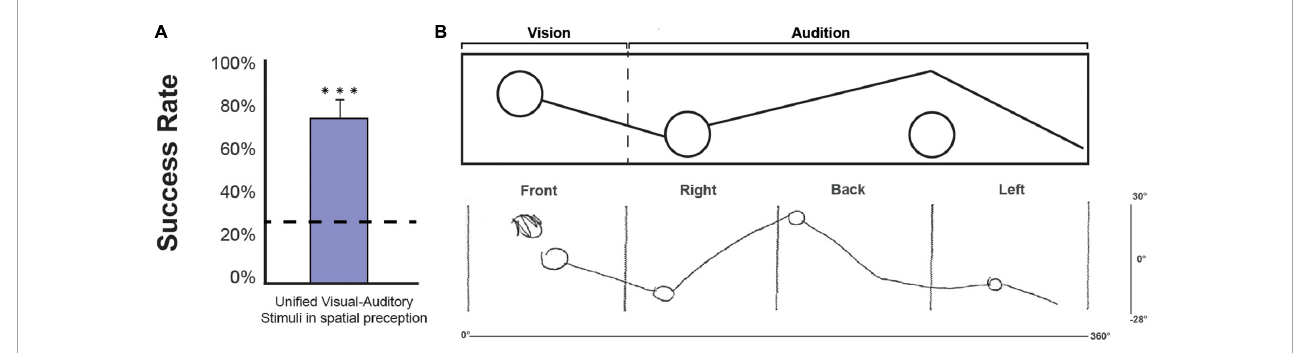
FIGURE5 (A) Group result for shapes that began in the visual field and continued auditorily. We performed a one-tailed one-sample Wilcoxon test against chance. The correct response rate was 76.6 ± 15.1%, significantly higher than the chance level (W(14) = 120, p < 0.001) (bar indicates the standard error; dashed line indicates chance level). (B) An example of a full visual-auditory stimulus as processed in the Vision360 application. The “vision” section of the stimulus is perceived by the participants in the front, and the “Audition” section is perceived by the participants auditorily (starting from left to right in relation to the participants’ location). Underneath the stimulus, an example of a drawing by participant number 9, taken from the drawing phase of the experiment is shown. Front | right | back | left are the space expressions standardizing the division of space for the participants according to their egocentric position in space. The x -axis of 0 ◦ –360 ◦ represents the horizontal coverage of the stimulus in space, and the y -axis of 30 ◦ –28 ◦ represents the vertical coverage of the stimulus in space. ***Means significantly above